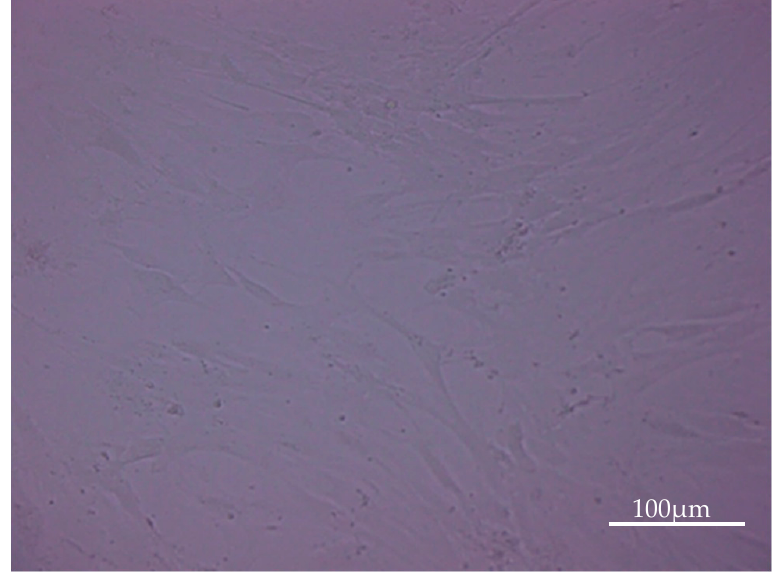
Figure 8. After incubation with avian IgYs for 24 h, osteoblasts were partially detached from the surface which indicates activation.